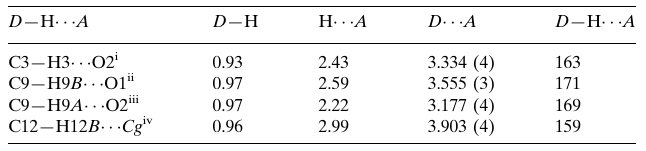
Hydrogen-bond geometry (A˚ , (cid:2) ). Cg is the centroid of the benzene ring